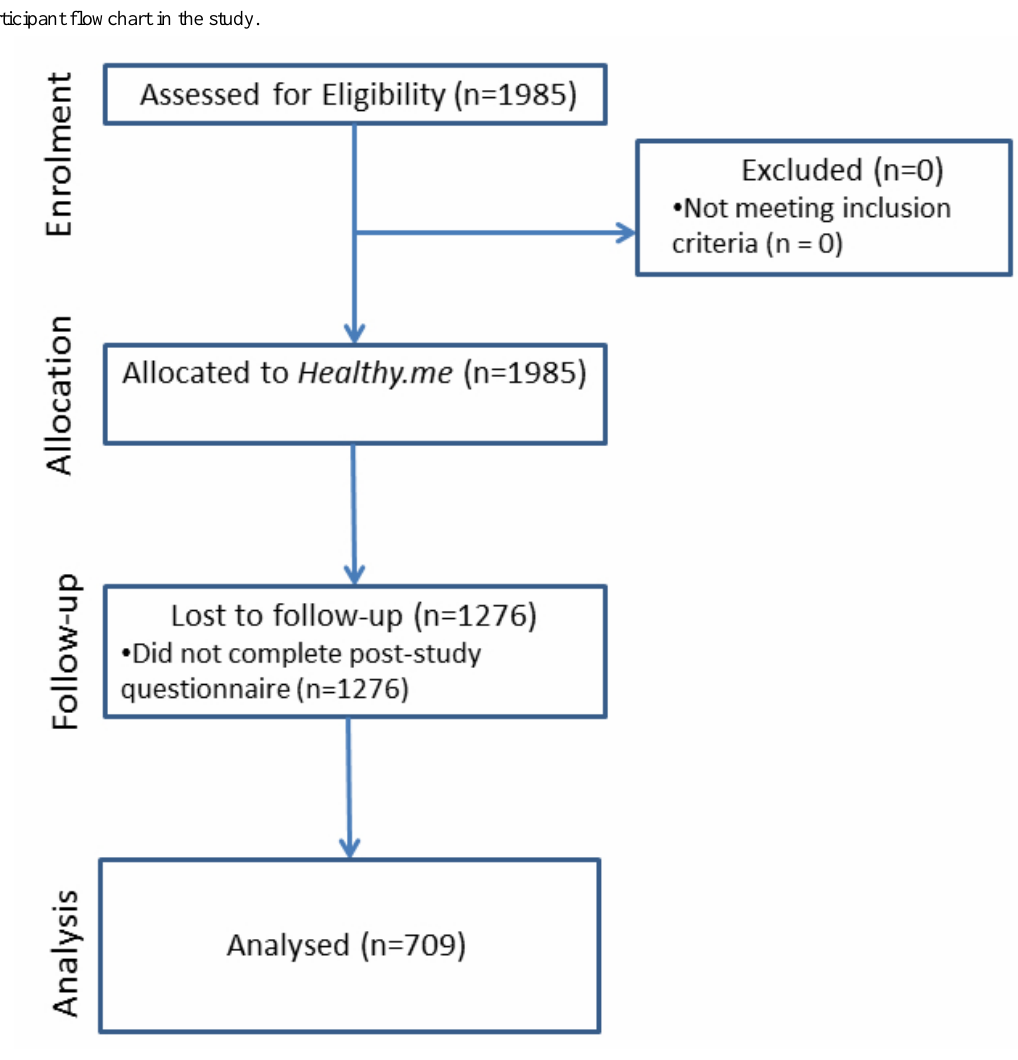
Figure 3. Participant flowchart in the